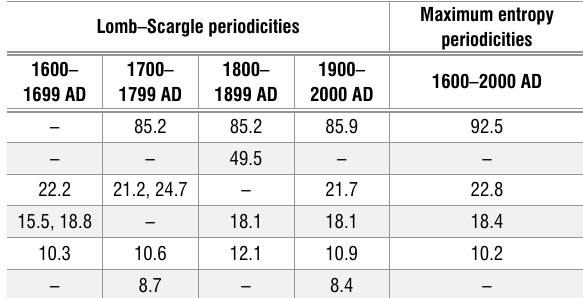
Figure 4: Lomb–Scargle spectral analysis of Pafuri baobab between (a) 1600 and 1699, (b) 1700 and 1799, (c) 1800 and 1899 and (d) 1900 and 2000. The black curves are spline fits of the periodicities revealed by the Lomb–Scargle method.